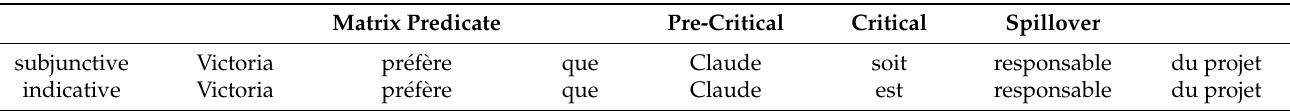
Table 3. Regions of interest in the current